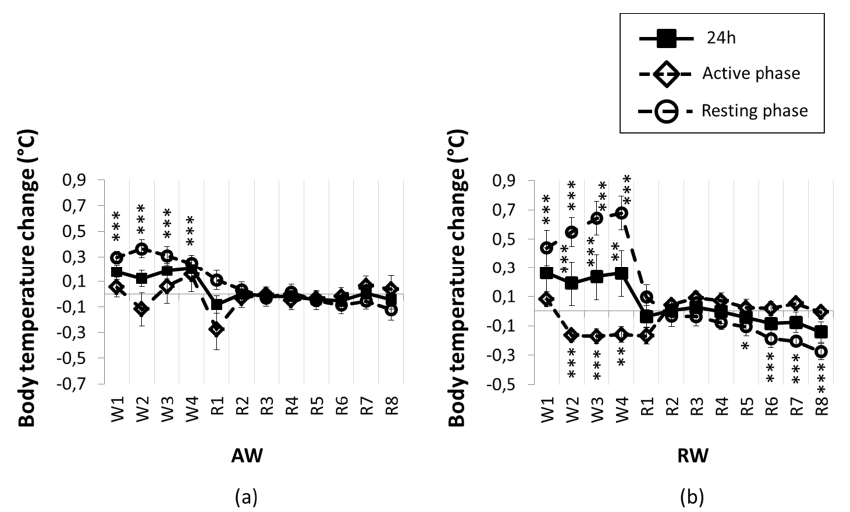
Figure 4. Mean body temperature during one shift work period (W1–4) and recovery (R1–8) for ( a ) active workers (AW) and ( b ) rest-workers (RW). Data are shown as mean percentage change relative to baseline. Error bars indicate SEM. W1–4 indicate work days 1 to 4. ** p < 0.01; *** p < 0.001, compared to baseline.